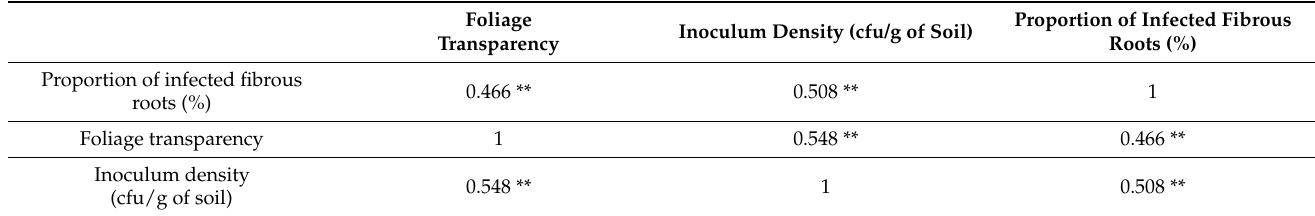
Table 2. Pearson correlation coefficients between foliage transparency, as determined according to the classification of Schomacher et al. [17] and Eichhorn et al. [18], and inoculum density of Phytophthora × cambivora , in terms of cfu/g of soil and proportion (%) of fine roots infected by P. × cambivora , in 40 randomly selected beech trees.